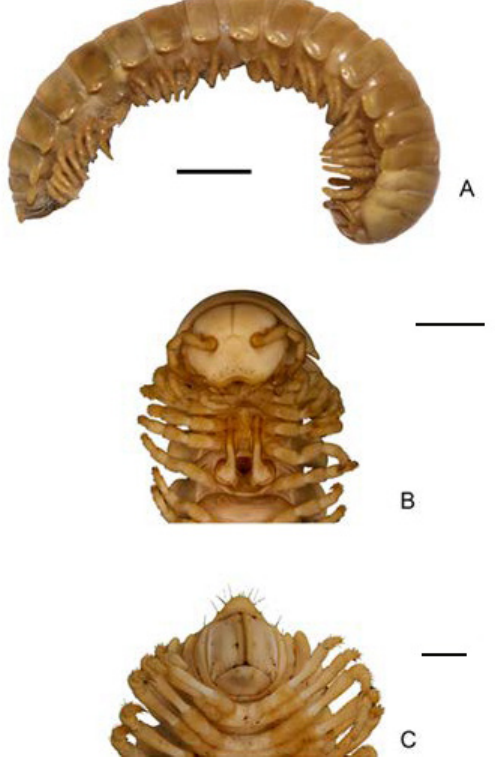
Fig. 12. Pogoropsis prolixopes Rosenmejer & Enghoff gen. et sp. nov., holotype, ♂ (NHMD 621672). A . Habitus. B . Front end, showing gonopods, ventral view. C . Hind end, ventral view. Scale bars: A = 5 mm; B = 3 mm; C = 1